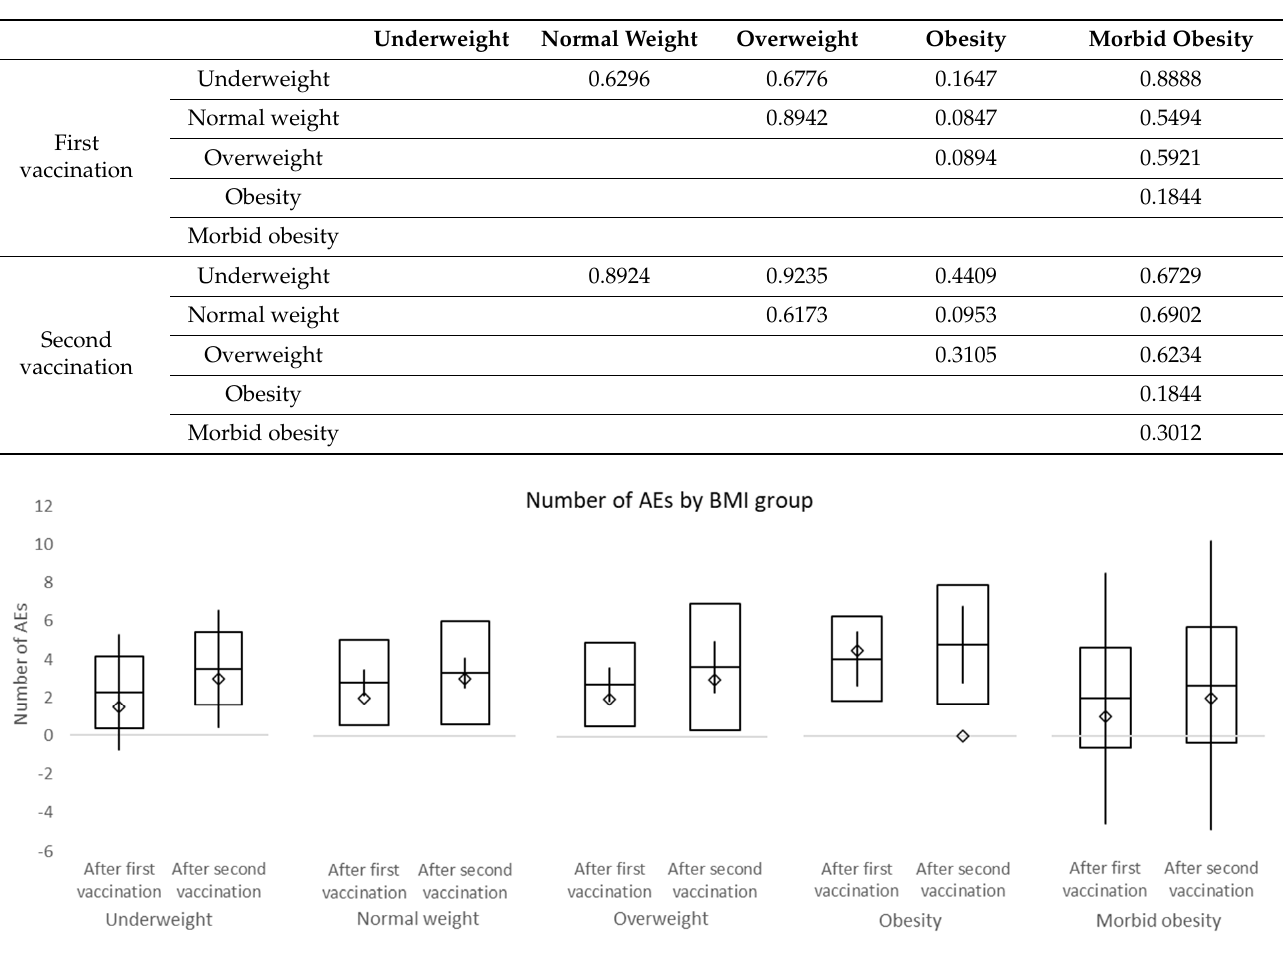
Figure 4. Number of adverse events by body mass index (BMI) groups. □ mean ± standard deviation; ◊ median; │ minimum − maximum.